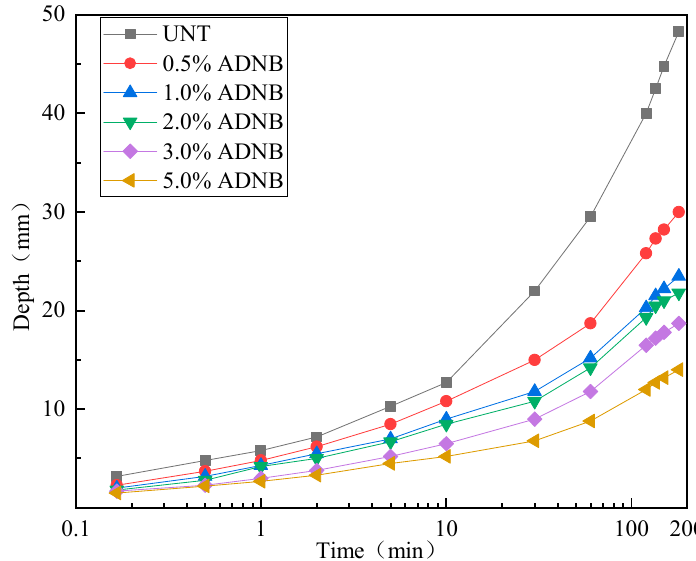
Figure 3. Evolution of the infiltration depth of the polymer solution or water.